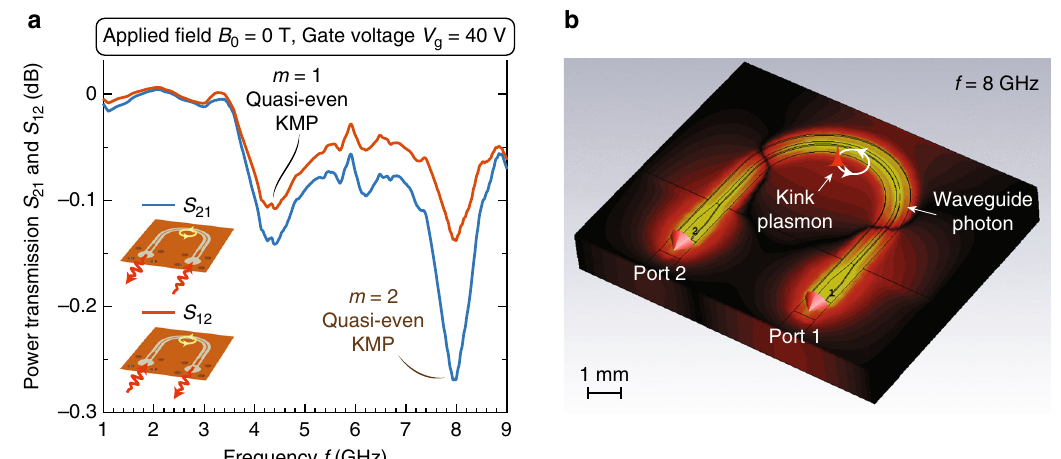
Fig. 4 Nonreciprocal transmission of kink magnetoplasmons (KMPs). a Measured power transmission along S 21 ( “ easy-coupling ” ) and S 12 ( “ hard- ¼ 40 V and zero applied magnetic fi eld. The distinct absorption depths manifests the nonreciprocal coupling ” ) directions, respectively, with gate voltage V g nature of the m ¼ 1 and 2 quasi-even KMPs. b Full-wave simulated mode pro fi le of long-wavelength microwave photons in the coplanar waveguide, in comparison to the small circle along which short-wavelength one-way KMPs